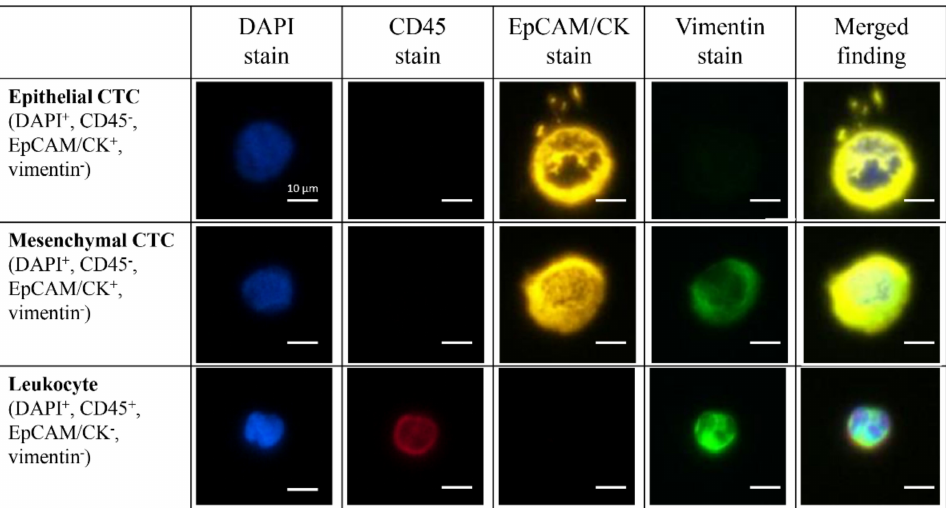
Figure 2. Representative images of epithelial-type CTCs (E-CTC), mesenchymal-type CTCs (M-CTC), and leukocytes (scale bar: 10 µ m). CTCs are greater than 15 µ m, DAPI-positive, CD45-negative, and EpCAM- or CK-positive (DAPI + , CD45 − , EpCAM/CK + ). E-CTCs were defined as CTCs without expression of vimentin (DAPI + , CD45 − , EpCAM/CK + , vimentin − ), and M-CTCs were defined as CTCs that express vimentin (DAPI + , CD45 − , EpCAM/CK + , vimentin + ). Leukocytes are stained for CD45.